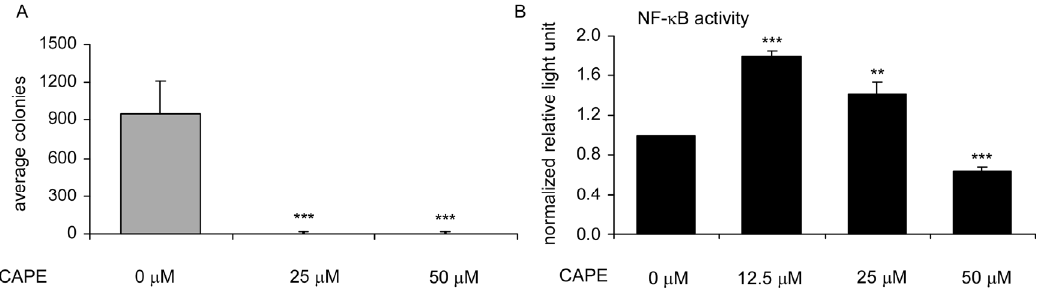
Figure 2. Effects of CAPE treatment on soft agar colony formation and NF- κ B activity of TW2.6 cells. ( A ) TW2.6 cells were treated with 0, 25, or 50 μ M CAPE for 16 days. Asterisk ( *** ) represents statistically significant difference ( p < 0.001) between the treated group and the control group; ( B ) TW2.6 cells were transfected with pRL-TK-Renilla luciferase plasmid and 4X NF- κ B reporter gene vector. Twenty four hours after transfection, cells were treated with 0, 12.5, 25, and 50 μ M of CAPE. After an additional 24 h, cells were lysed in 100 μ L passive lysis buffer and luciferase activity was measured using a Dual-Luciferase kit (Promega) in a 20/20 n luminometer Turner Biosystems. Experiments were repeated three times. Error bars represented standard